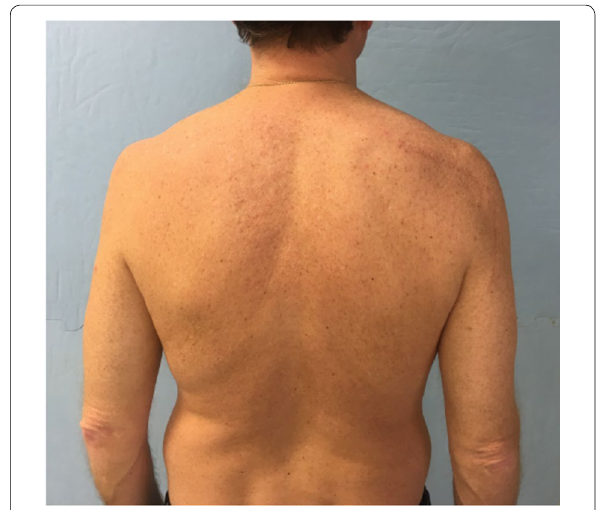
Fig. 4 Patient who underwent the modified Judet